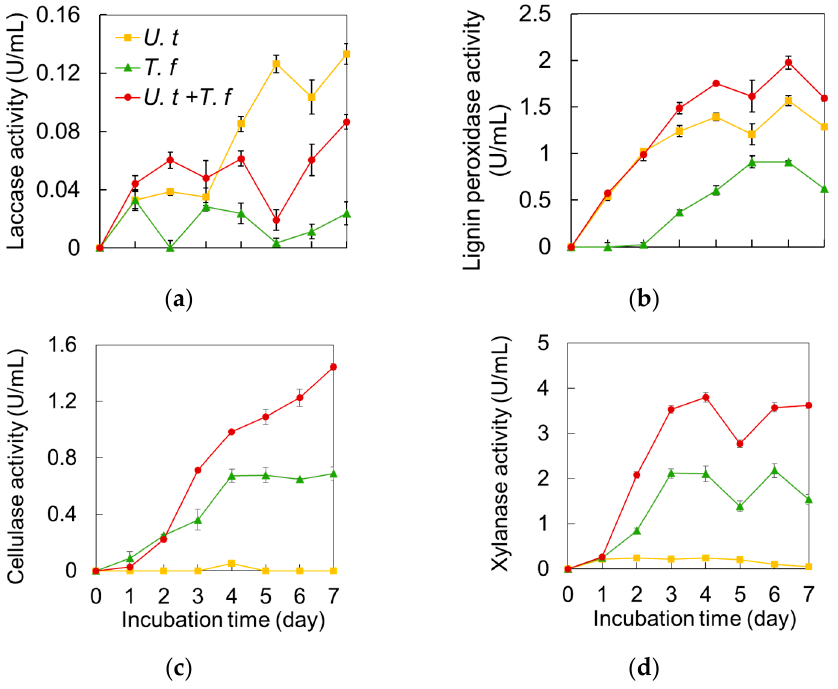
Figure 2. Laccase activity ( a ), lignin peroxidase activity ( b ), cellulase activity ( c ), and xylanase activity ( d ) in cultures of T. fusca , U. thermosphaericus and both strains.